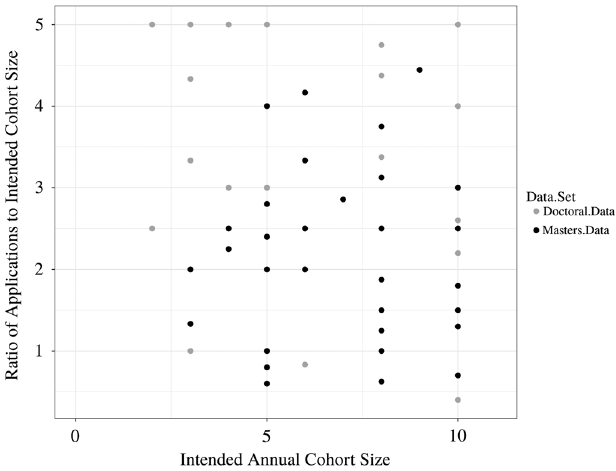
FIG. 5. Subset of similar “ sized ” and “ pressured ” master ’ s ( n ¼ 33 ) and Ph.D. ( n ¼ 28 )